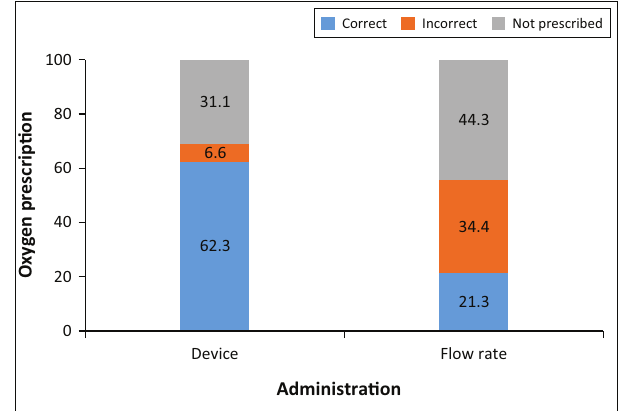
FIGURE 1: Oxygen prescription versus administration.